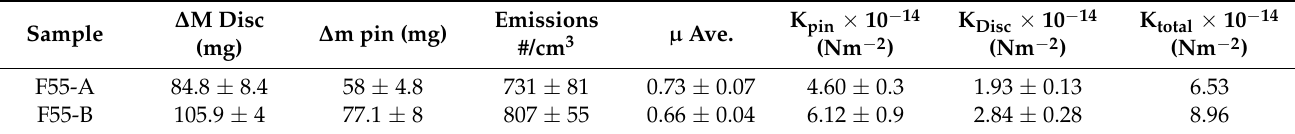
Table 4. Summary of the PoD tests’ results .